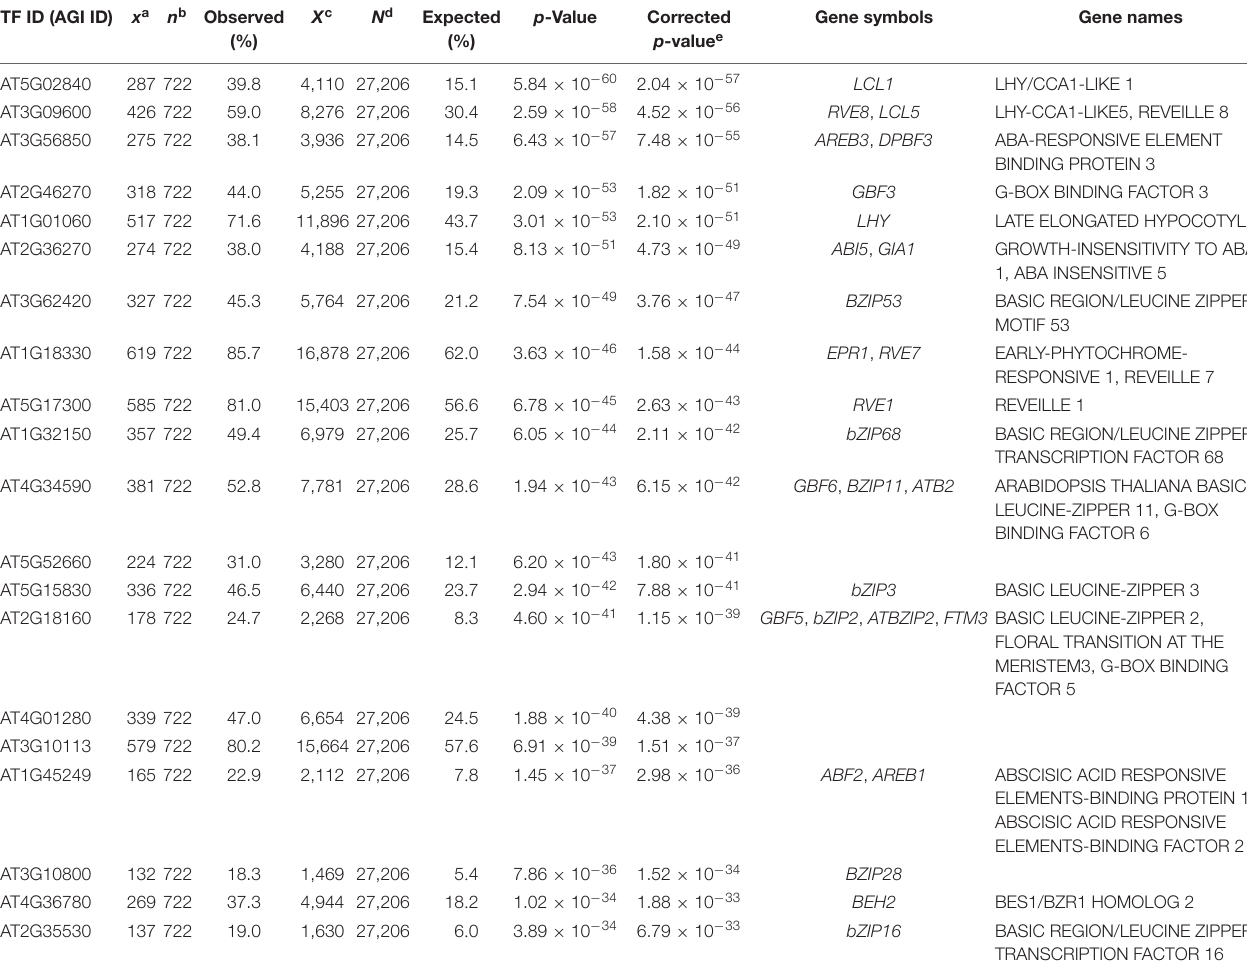
TABLE 1 | Summary statistics of the upstream transcription factor (TF) enrichment analysis for the Arabidopsis gene set bound by LHY (Adams et al.,